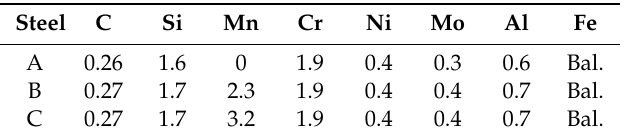
Table 1. Chemical compositions of tested steels (wt%) (Data from [6]).